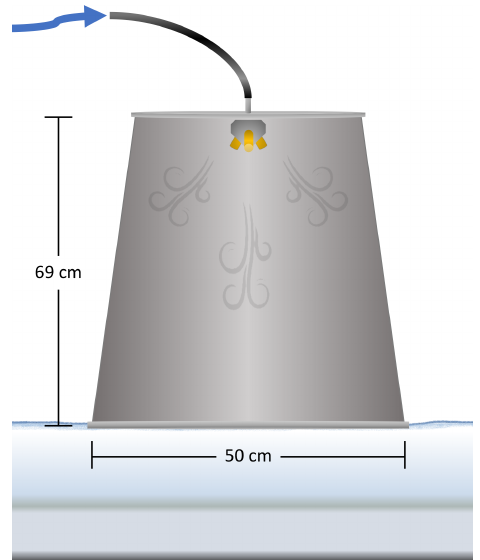
Figure 2. The deposition chamber for all aerosol types consists of a near-cylindrical volume with aerosols pumped into the inlet at the top of the chamber from the production or entrainment chamber.